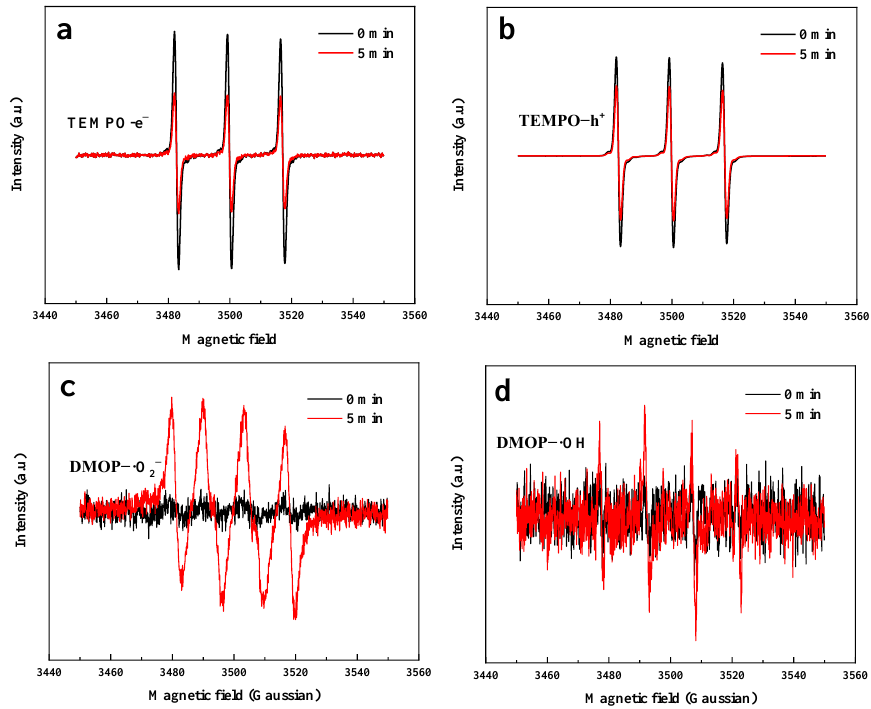
Figure 13. The ESR spectra of ZCS/1CSO under dark (0 min) and visible light (5 min), ( a ): TEM- PO-e − , ( b ): TEMPO-h + , ( c ): DMOP-O 2 − and ( d ): DMOP-OH.